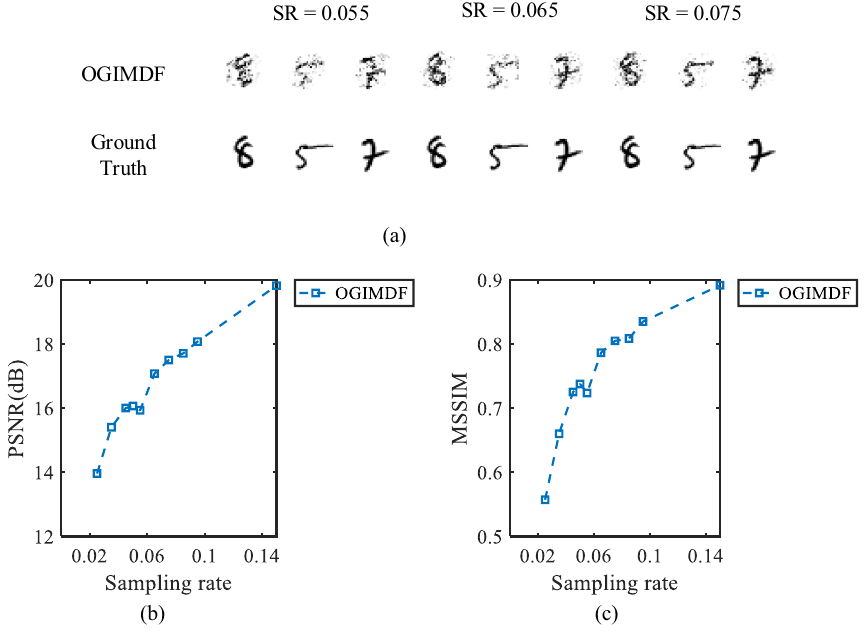
Figure 3. Simulation results of the OGIMDF method at the low SRs. The SR is between 0.025 and 0.15. ( a ) The images in the first row are reconstructed using OGIMDF method, and the images in the second row are the ground truth. ( b ) and ( c ) show the change curves of PSNR and MSSIM of reconstructed images using OGIMDF under different SRs, respectively.